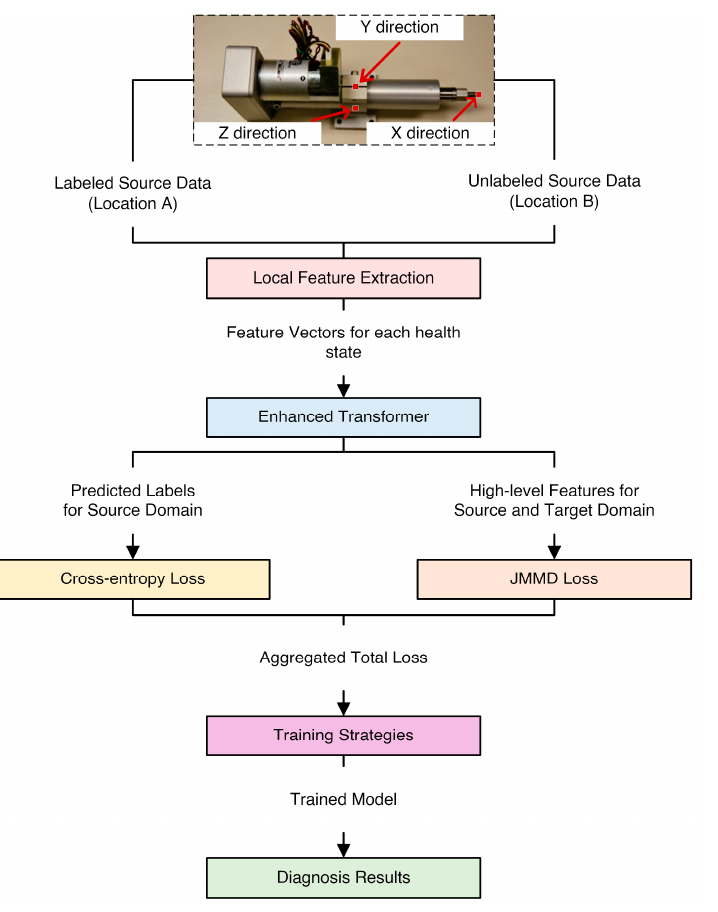
Figure 1. Schematic of the proposed analysis pipeline.